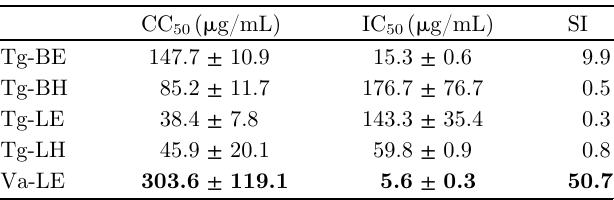
Table 2. Cytotoxicity on HFF and anti- Toxoplasma ef fi cacy of the plant extracts.